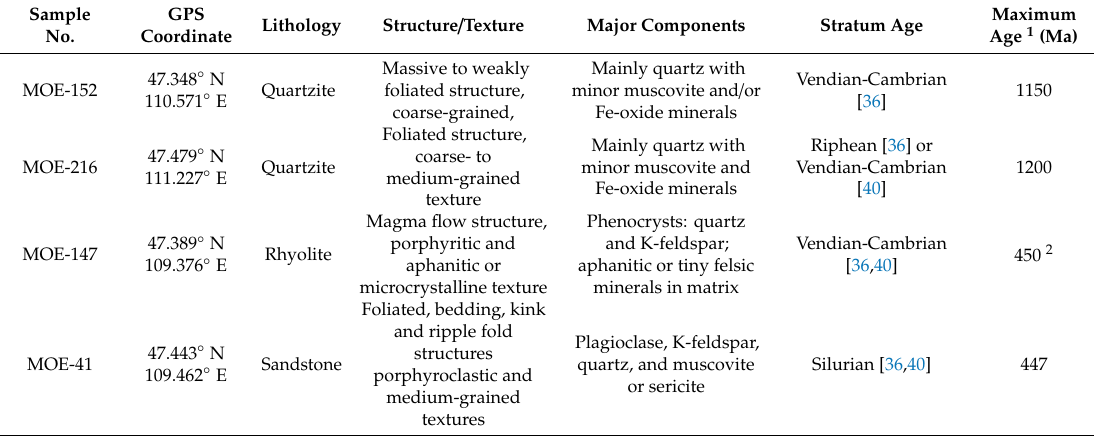
Table 1. Summary of basic petrographic features of analyzed samples from NE Mongolia. Sample